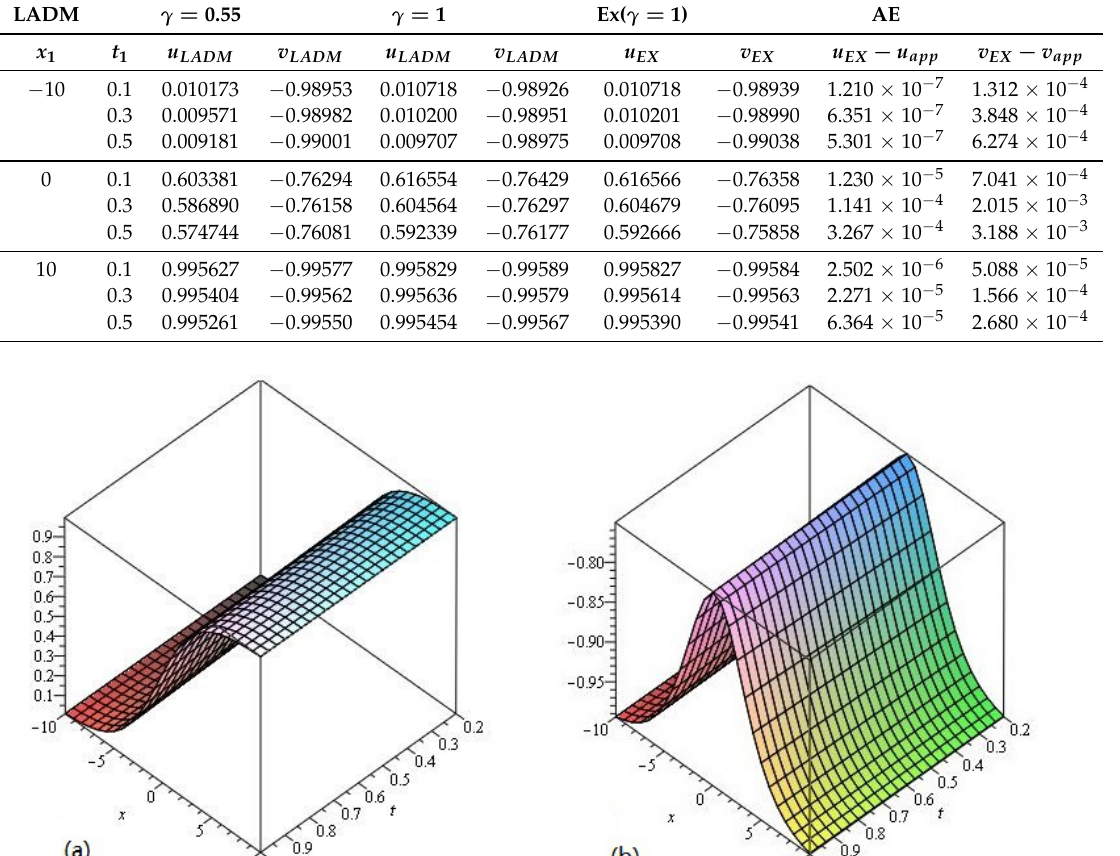
Table 2. Solution of LADM for different value of γ when η = 0.001 and Absolute Error of Example 2.